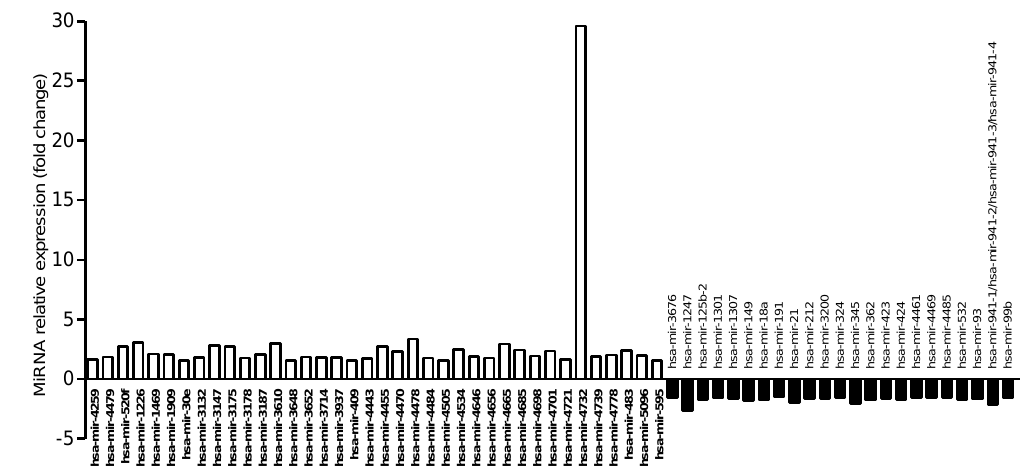
Figure 4. Dysregulated miRNAs in AIEC LF82-infected versus uninfected M cells. A total of 10 7 LF82 bacteria were added into the apical compartment of M cells. At 4 h post-infection, the monolayers were collected, washed with cold PBS, and total RNA was extracted and used for miRNA array analysis. The graph shows the relative expression of the miRNAs that were dysregulated in AIEC LF82-infected versus uninfected M cells, presented as fold change (normalized to expression levels of miRNAs in uninfected M cells, defined as 1).